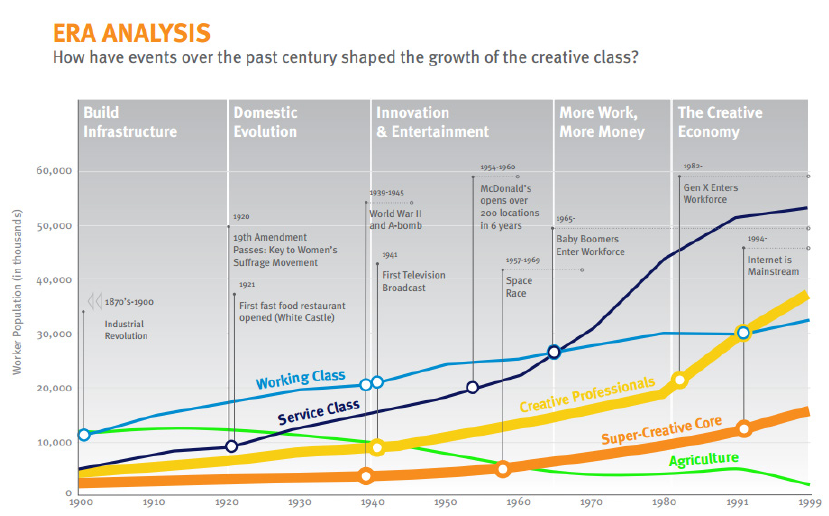
Figure 1. Worker population in the United States in the 20th century, in thousands (source: created by author, according to Florida,